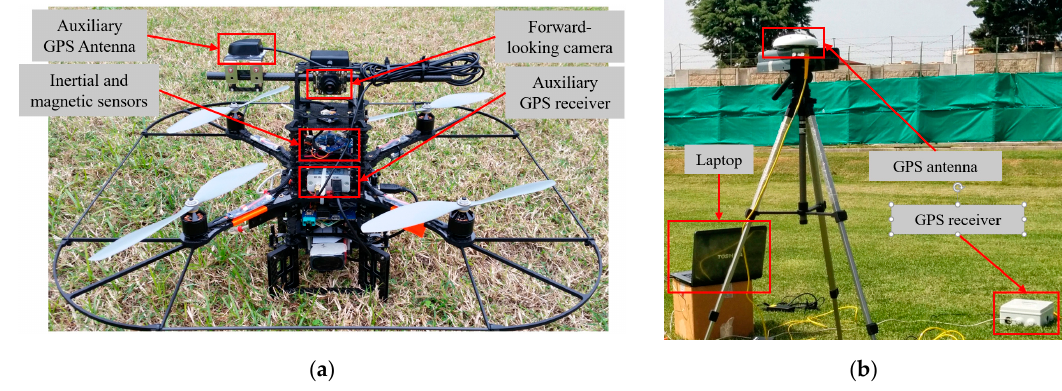
Figure 3. (a) Pelican quadcopter used as chief UAV. (b) Fixed ground station used as